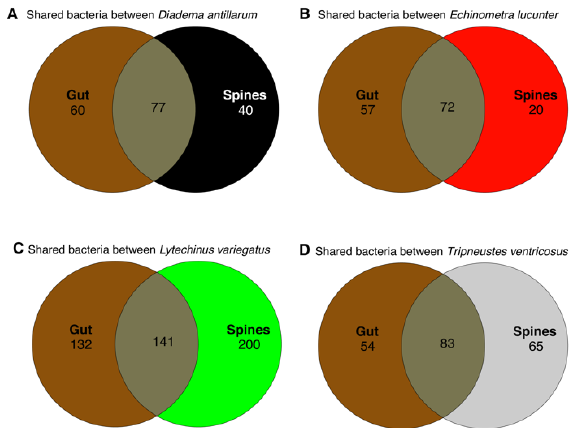
Figure 2. Venn diagram modeling shared and unique genus-level taxa considering core taxa with detection of 0.001 among the four sea urchin species in the gut and spine samples. Gut sample data used in this analysis were previously published [4].